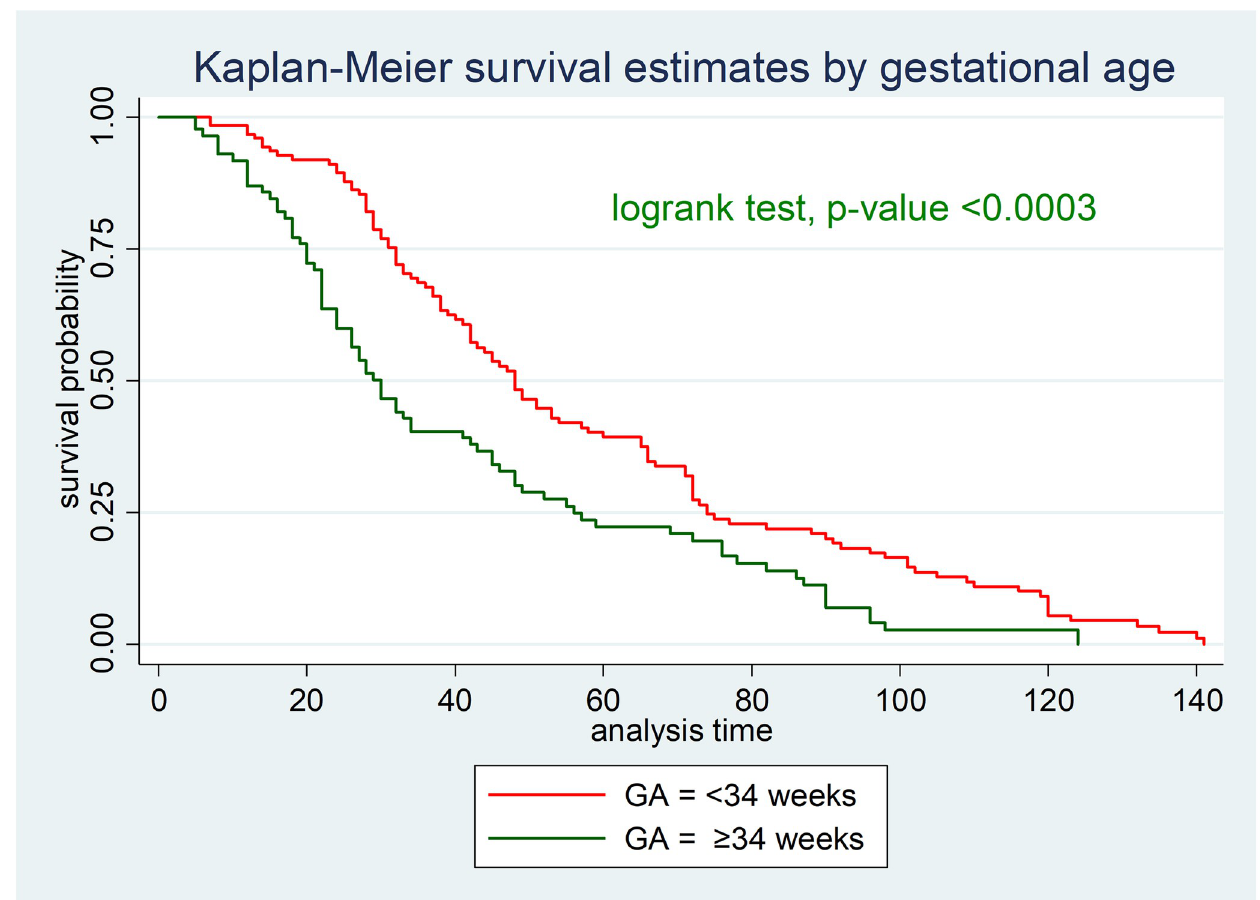
Fig 2. Kaplan-Meier survival estimate of starting TF based on the gestational age of neonates admitted in NICU of DMCSH, FHCSH, and TGCSH, Amhara, Northwest Ethiopia from October to November/2020 (n = 210).